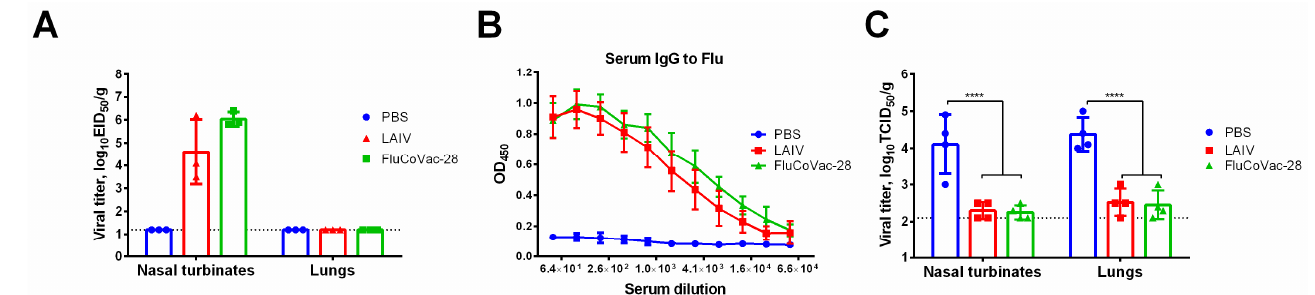
Figure 6. The replication and anti-influenza immune response, as well as protection of the studied viruses in Golden Syrian hamsters. Groups of Syrian hamsters were inoculated twice with 5 × 10 6 EID 50 of LAIV or FluCoVac-28 or were mock-immunized with PBS with 3-week interval. ( A ) Infectious viral titers in the respiratory tissues on day 3 after first inoculation. ( B ) Influenza-specific antibody responses as determined by ELISA against whole LAIV virus in serum samples collected three weeks after the second dose. ( C ) Infectious titers in the respiratory tissues on day 4 after challenge with homologous influenza virus. Data were analyzed by two-way ANOVA with Tukey’s post-hoc multiple analyses test. ****— p < 0.0001.